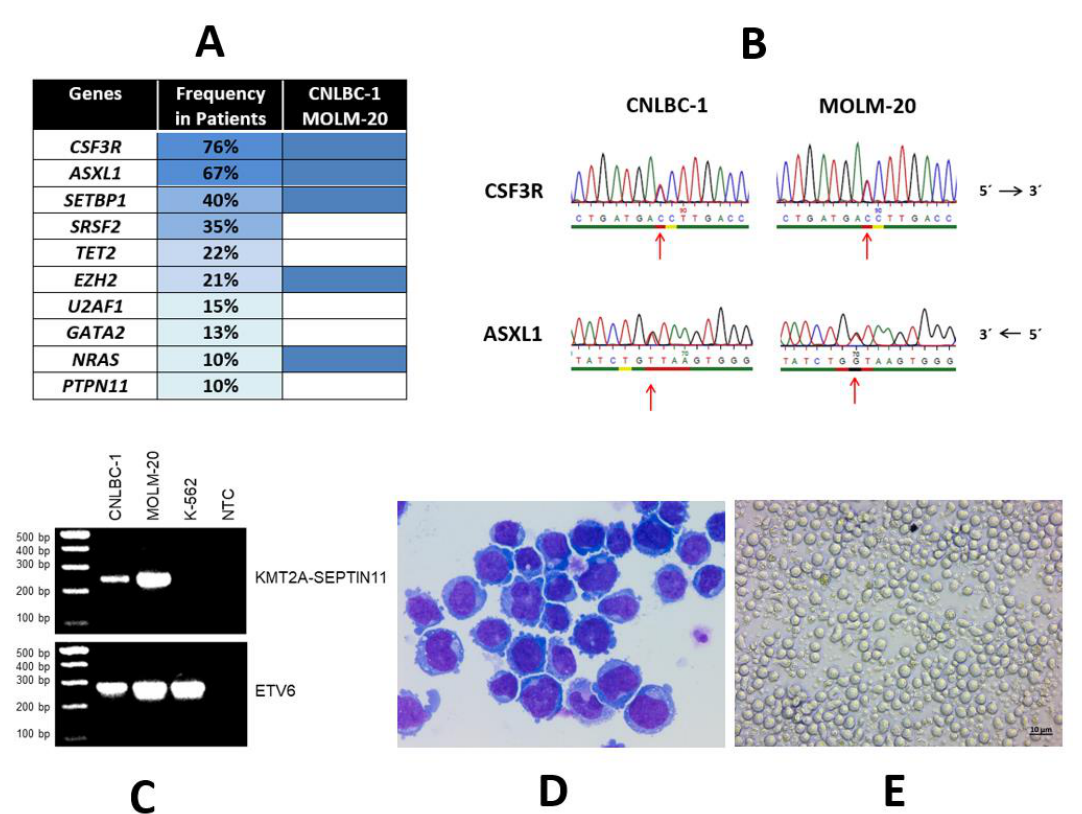
Figure 1. Mutational landscape of CNL and characteristics of CNL cell lines CNLBC-1 and MOLM-20. ( A ) Mutational landscape in CNL. Left column: mutated genes; middle column: frequency of mutations in primary cases (the mutation frequency of the listed genes was calculated from several case series [6,10–14]; right column: mutations present in CNL cell lines CNLBC-1 and MOLM-20. While CSF3R mutations are associated with CNL, ASXL1 is frequently mutated in various myeloid malignancies, including myelodysplastic syndromes, chronic myelomonocytic leukemia, and acute myeloid leukemia. SETBP1 mutations are found in several myelodysplastic/myeloproliferative entities. ( B ) Characteristic genomic alterations in CNLBC-1 and MOLM-20. Shown here: point mutations in CSF3R (T618I, COSM4169901/COSM1737962) and ASXL1(Y591*, COSM1681609) detected with Sanger sequencing in both CNLBC-1 and MOLM-20. ( C ) Cytogenetic alterations of CNLBC-1 and MOLM-20 which also carry a t(4;11)(q21;q23) leading here to the fusion gene KMT2A-SEPTIN11 [18]. Shown here: reverse transcription polymerase chain reaction analysis of fusion gene KMT2A-SEPTIN11 in CNLBC-1 and MOLM-20; additionally, cell line K-562 (derived from CML) was used as negative control; ETV6 served as control for cDNA used; NTC, no template control. This t(4;11)(q21;q23) should not be confused with the cytogenetically identical t(4;11)(q21;q23) which molecularly leads to the fusion KMT2A-AFF1 (formerly known as MLL-MLLT2) and which occurs CNLBC-1 cells. Shown here: May–Grünwald–Giemsa-stained cells after cytospin centrifugation on glass slide. ( E ) Cell culture of CNLBC-1 cells. Shown here: cells grown in suspension culture in 24-well plate. Cell line CNLBC-1 was